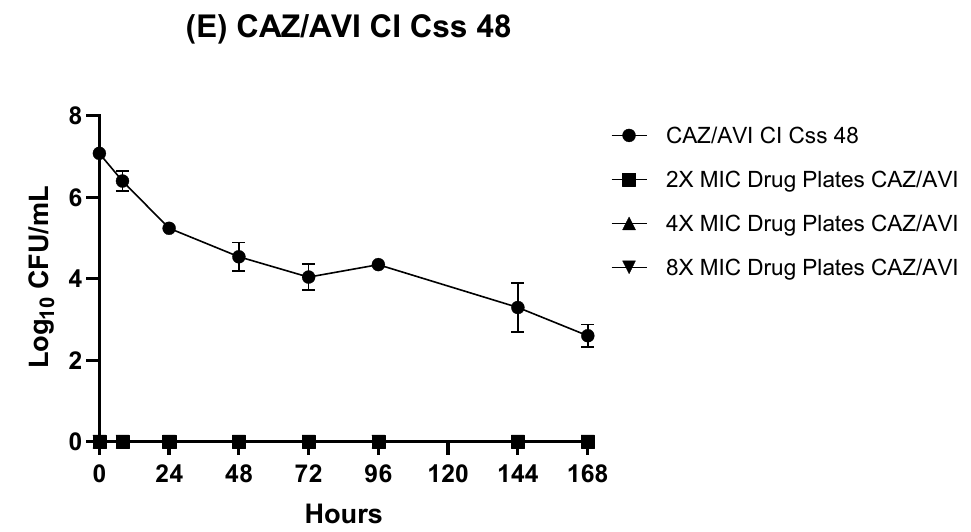
Figure 2. ( A – E ) Emergence of CAZ-AVI-resistance in the XDR P. aeruginosa isolate using Css of 12 (2 × MIC), 18 (3 × MIC), 30 (5 × MIC) and 48 (8 × MIC) mg/L in CI (performed in duplicate). CFU, colony-forming unit; CAZ/AVI, ceftazidime/avibactam; CI, continuous infusion; Css, steady-state concentrations; MIC, minimum inhibitory concentration. Errors bars are expressed as standard deviations (SD). Table 1. Whole genome sequence resistome analysis of the studied P. aeruginosa clinical isolates and derived resistant mutants. PA, P. aeruginosa ; CAZ/AVI, ceftazidime/avibactam; MIC, minimum inhibitory concentration; HFIM, hollow-fiber infection